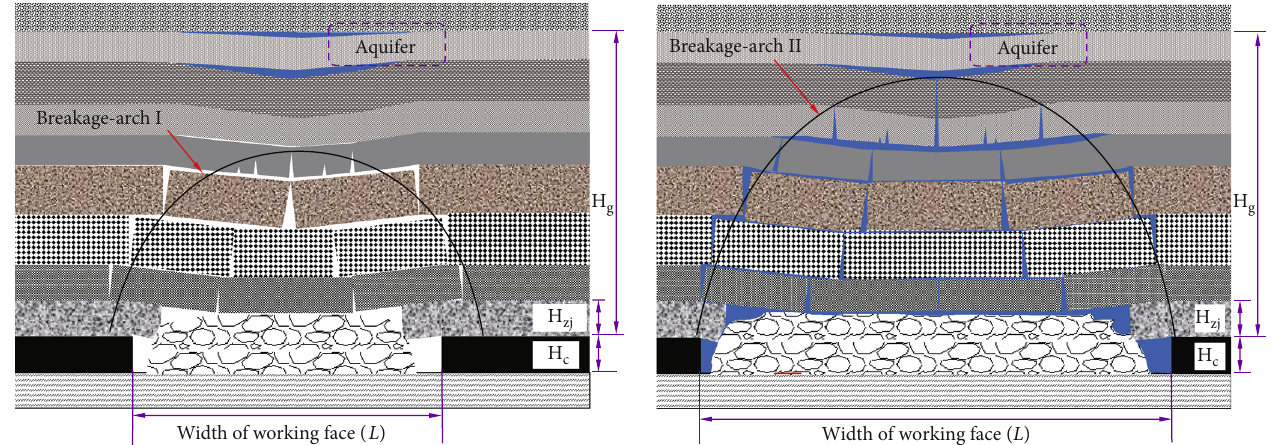
Figure 6: The relationship between the development height of “ Breakage-arch ” and water-bearing strata.